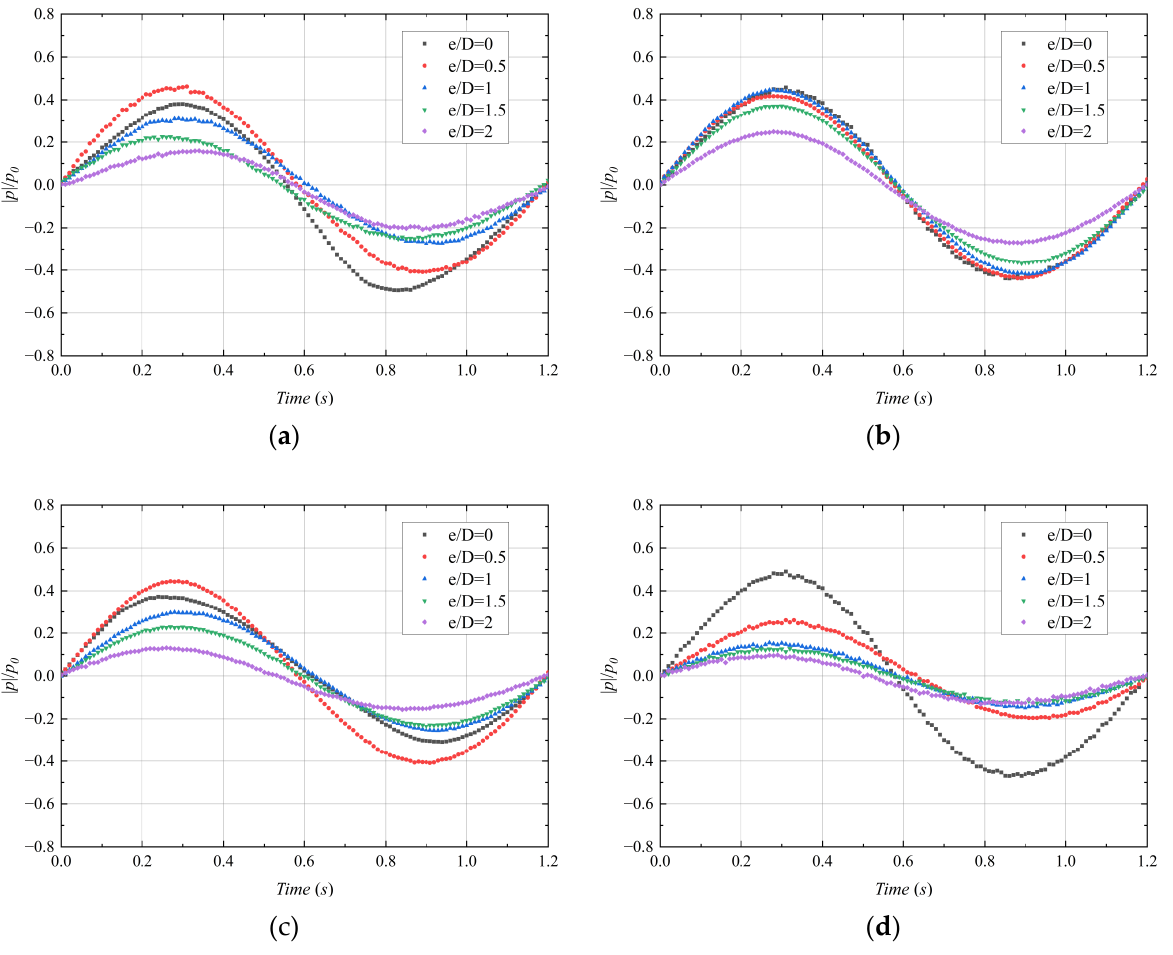
Figure 3. Variation curve of the dimensionless pore pressure amplitude around the pipeline under different backfill depths. ( a ) P1; ( b ) P2; ( c ) P3; ( d ) P4.